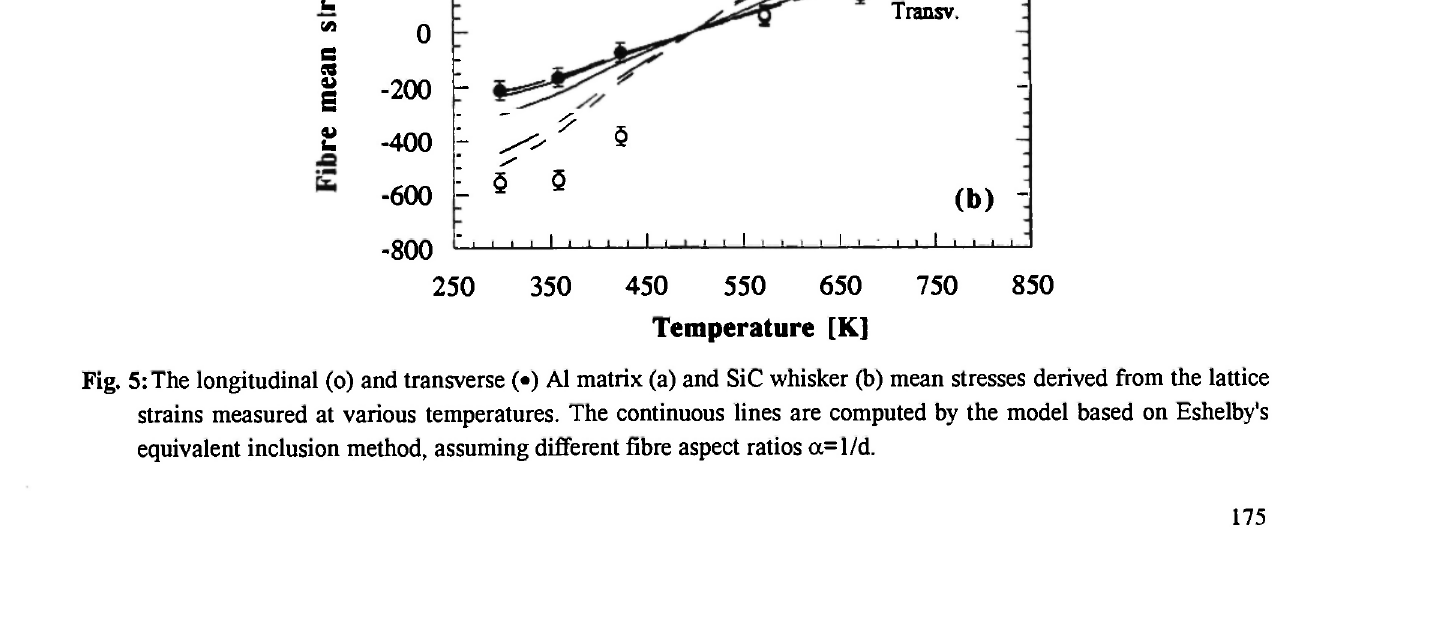
Fig. 5: The longitudinal (ο) and transverse (·) Al matrix (a) and SiC whisker (b) mean stresses derived from the lattice strains measured at various temperatures. The continuous lines are computed by the model based on Eshelby's equivalent inclusion method, assuming different fibre aspect ratios